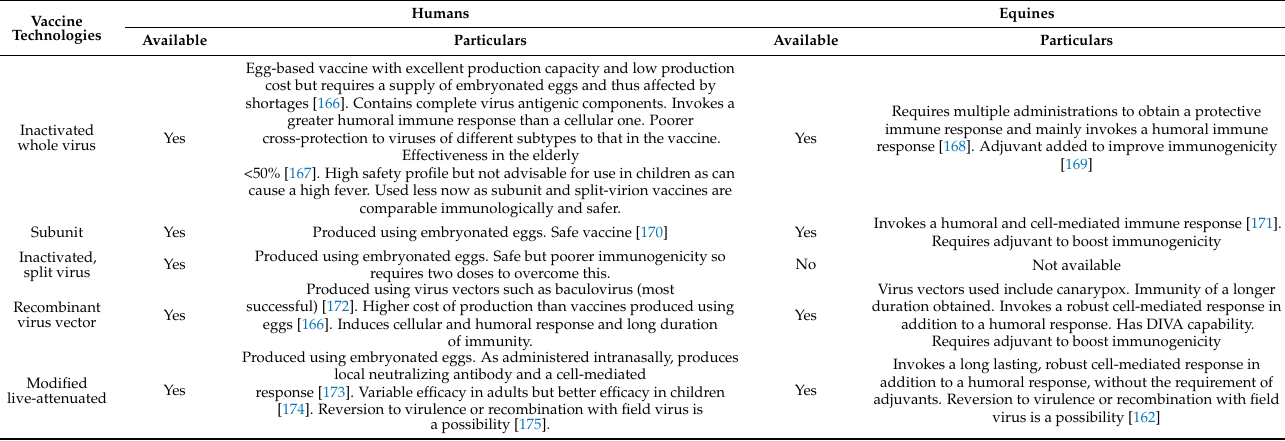
Table 1. A comparison of human and equine influenza commercially available